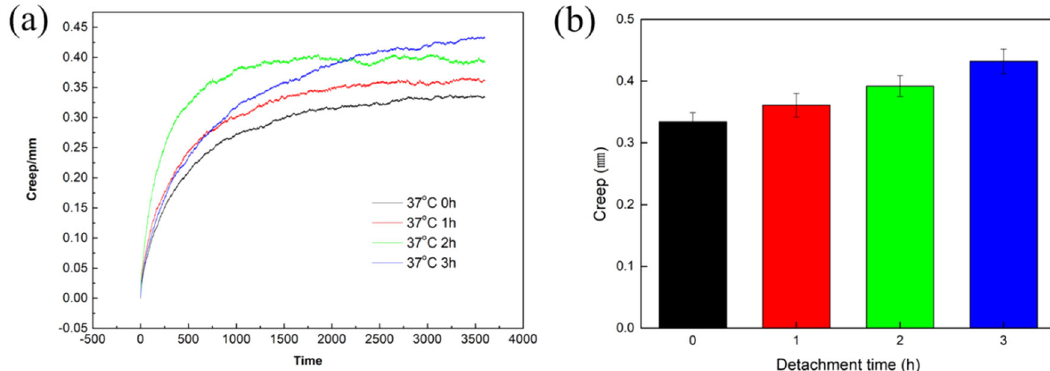
Fig. 4 Creep of articular cartilage at different times in vitro. ( a ) time-dependent curve of creep, ( b ) creep at last stage